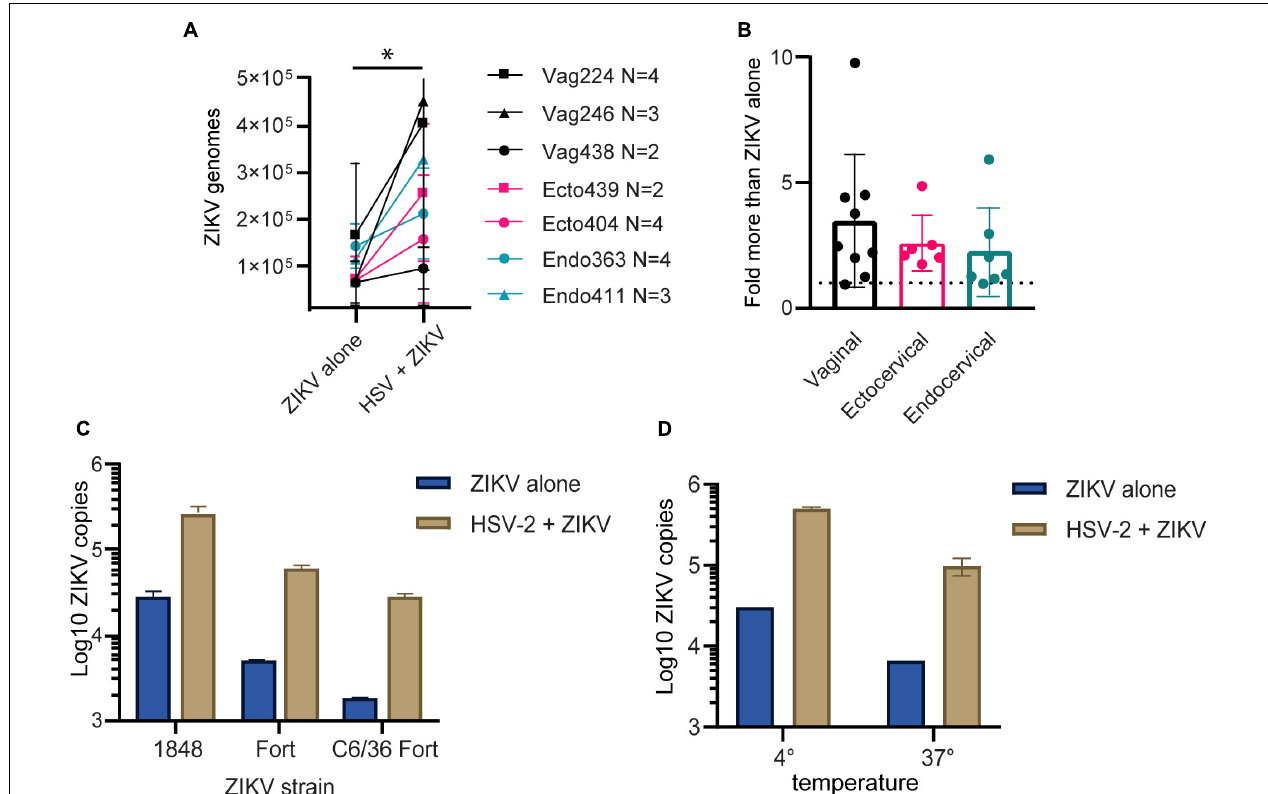
FIGURE 1 | HSV-2 infection leads to enhanced binding of ZIKV virus to cells. (A) Cells pre-infected with HSV-2 (strain 186) bind more ZIKV. Three vaginal (in black) and two each ectocervical (in teal) and endocervical (in pink) cell lines were infected with HSV-2 at an MOI of 0.1 for 24 h, or left uninfected. Then cells were exposed to ZIKV at an MOI of 1.0 for 1.5 h, washed 1x with PBS, and lysed for quantification of ZIKV binding and uptake by quantitative RT-PCR. Data are normalized to RPP30 gene expression and are shown as calculated total genome copies of ZIKV (see section “Materials and Methods”). Each color represents a different tissue origin, and each symbol is a different donor. Results are averaged from 2 to 4 independent experiments for each cell line, error bars are 1 standard deviation. Higher ZIKV in HSV-2 infected wells is significant ( ∗ ) by Wilcoxan matched-pairs signed rank test, p = 0.0156. (B) Data from A, plotted as fold more ZIKV in HSV-2 infected wells, for each independent experiment. (C) ZIKV binding to HSV-2 infected cells is enhanced with different ZIKV isolates and different producer cells. ZIKV strains 1848 and Fortaleza (Fort) were produced in Vero cells, and Fort was also produced in C6/36 insect cells. Ectocervical cells were infected with HSV-2 GFP strain 333 as described above, then exposed to ZIKV at an MOI of 1 for 1.5 h prior to quantification of ZIKV genomes by RT-qPCR. (D) Enhanced binding of ZIKV to HSV-2 infected cells occurs at both 4 ◦ and 37 ◦ Celsius. Vaginal cells were infected with HSV-2, then exposed to ZIKV for 1.5 h at either 4 ◦ or 37 ◦ prior to washing and genome quantification by